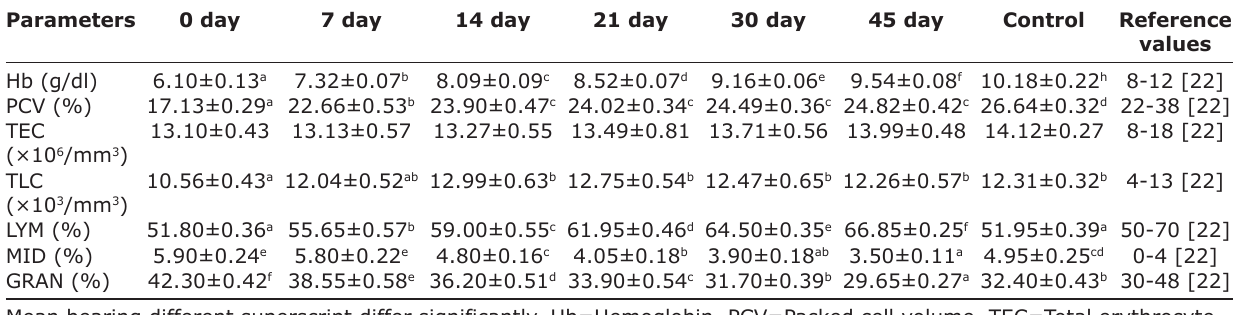
Table-1: Hematological profile (mean±SE) in Surti goats during the post-partum period. Parameters